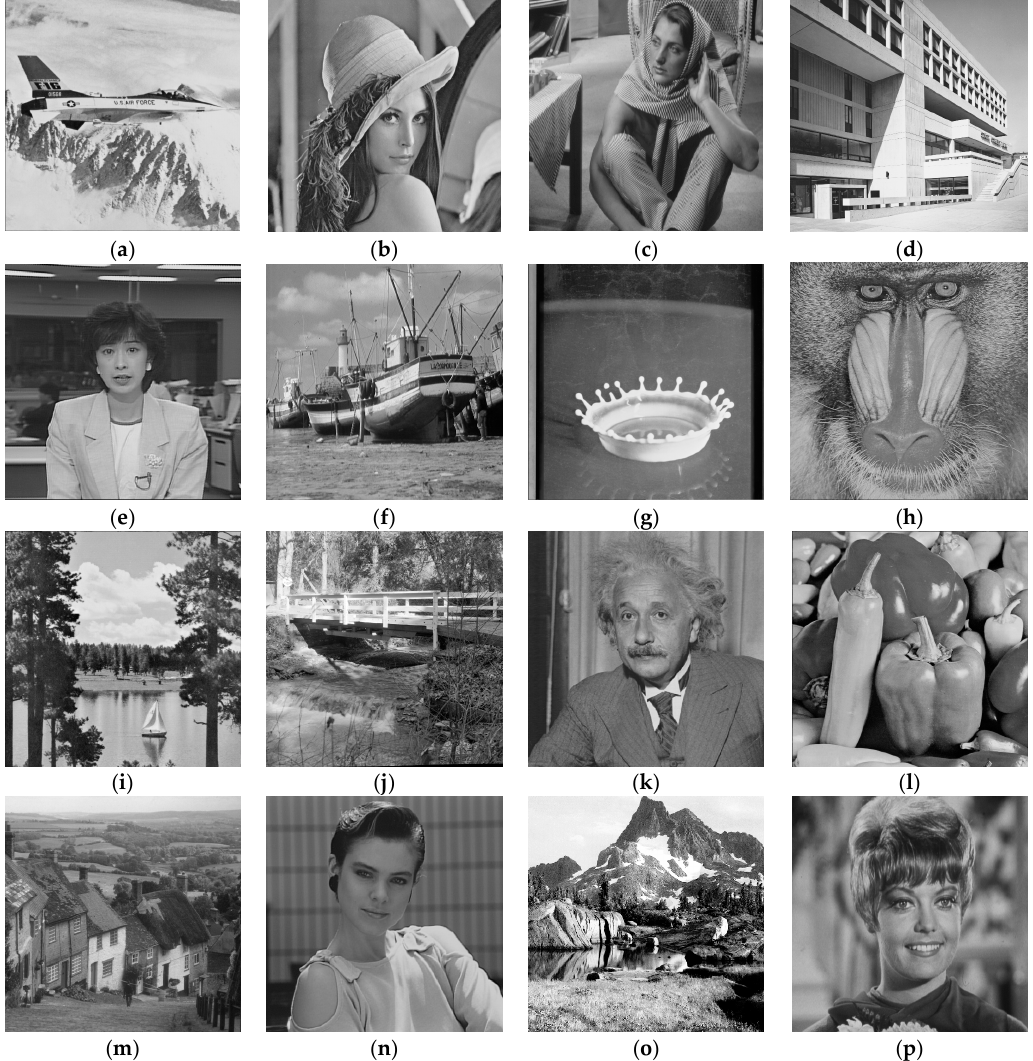
Figure 8. Test images: ( a ) Airplane; ( b ) Lena; ( c ) Barbara; ( d ) Bank; ( e ) Announcer; ( f ) Fishing Boat; ( g ) Milkdrop; ( h ) Baboon; ( i ) Boat; ( j ) Bridge; ( k ) Einstein; ( l ) Peppers; ( m ) Goldhill; ( n ) Model; ( o ) Mountain; ( p ) Zelda.